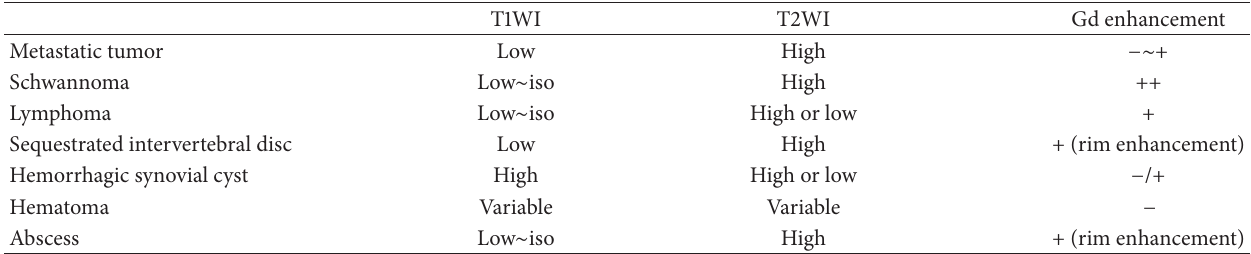
Table 1: The differential diagnosis according to MRI findings of the epidural space occupying lesion.